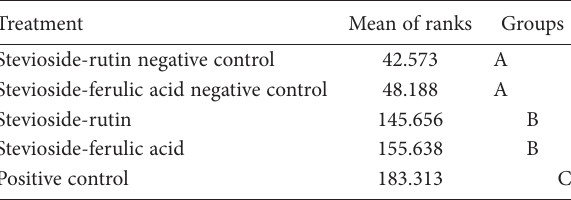
Table 3. Mean lengths of the vascular necroses in grapevine plants after inoculations with Neofusicoccum parvum . Mean of rank values accompanied by the same letters are not significantly different ( P < 0.05; Kruskal-Wallis test, and multiple pairwise comparisons using the Conover-Iman procedure).